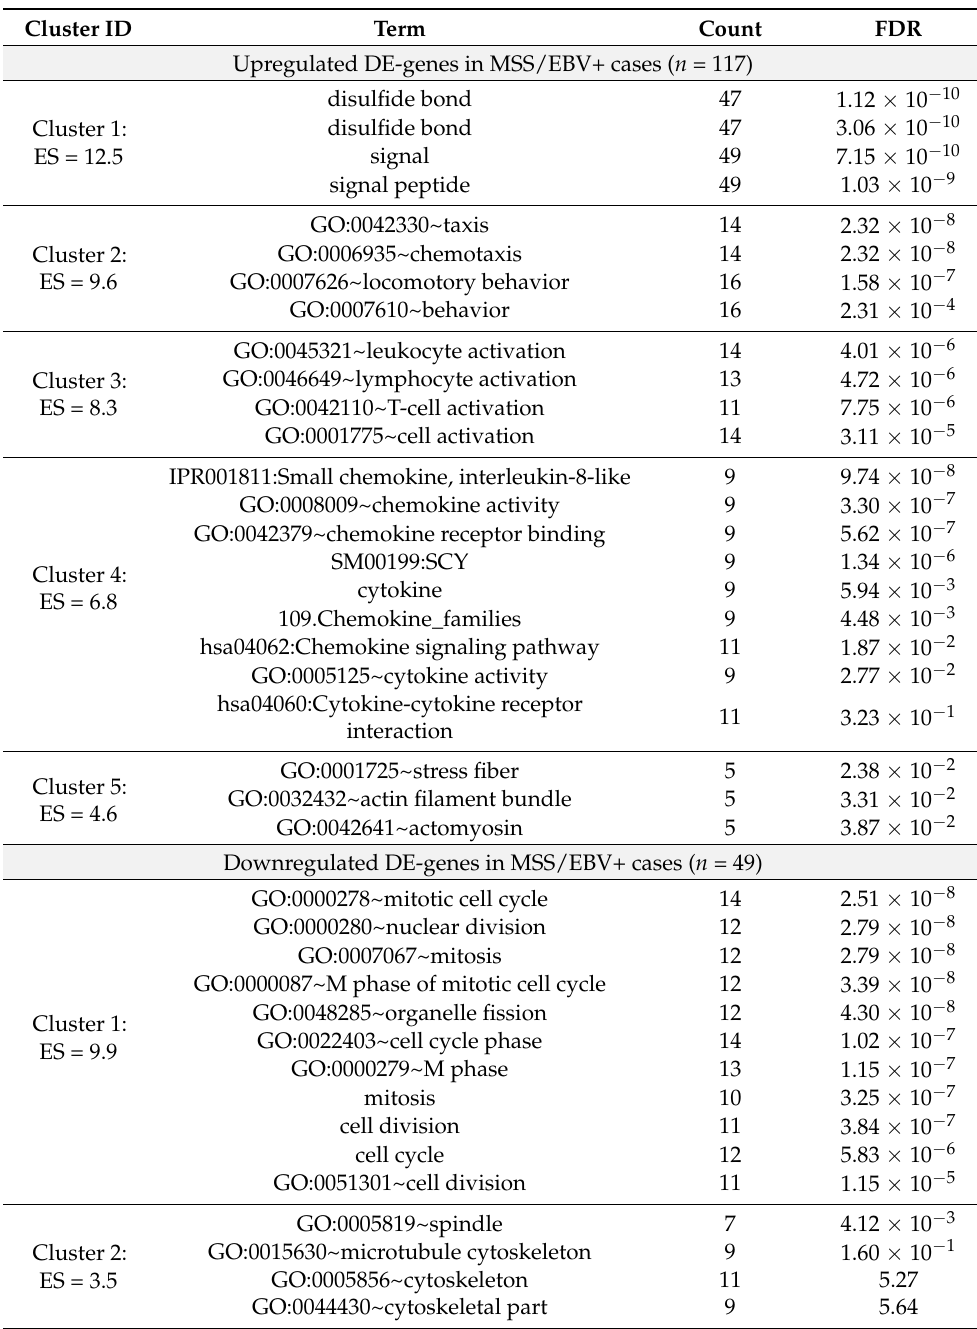
Table 7. Functional annotation clustering results for the 166 DE-genes derived from the comparison of MSS/EBV+ cases vs. MSI-high/EBV − cases. Notice that some terms among clusters are not significantly enriched (FDR >